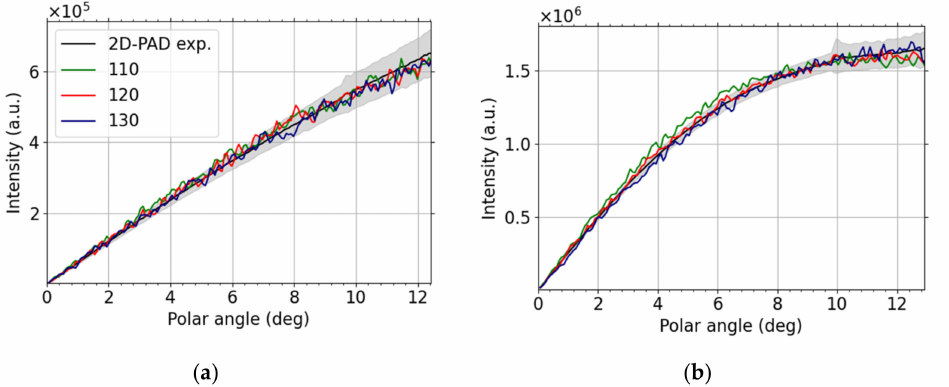
Figure 9. Mo, ( a ) 15 keV and ( b ) 30 keV, experimental (black with gray error stripe) and theoretical results for different thicknesses based on MC simulations with 10 6 particles freely propagated to the 2D-PAD